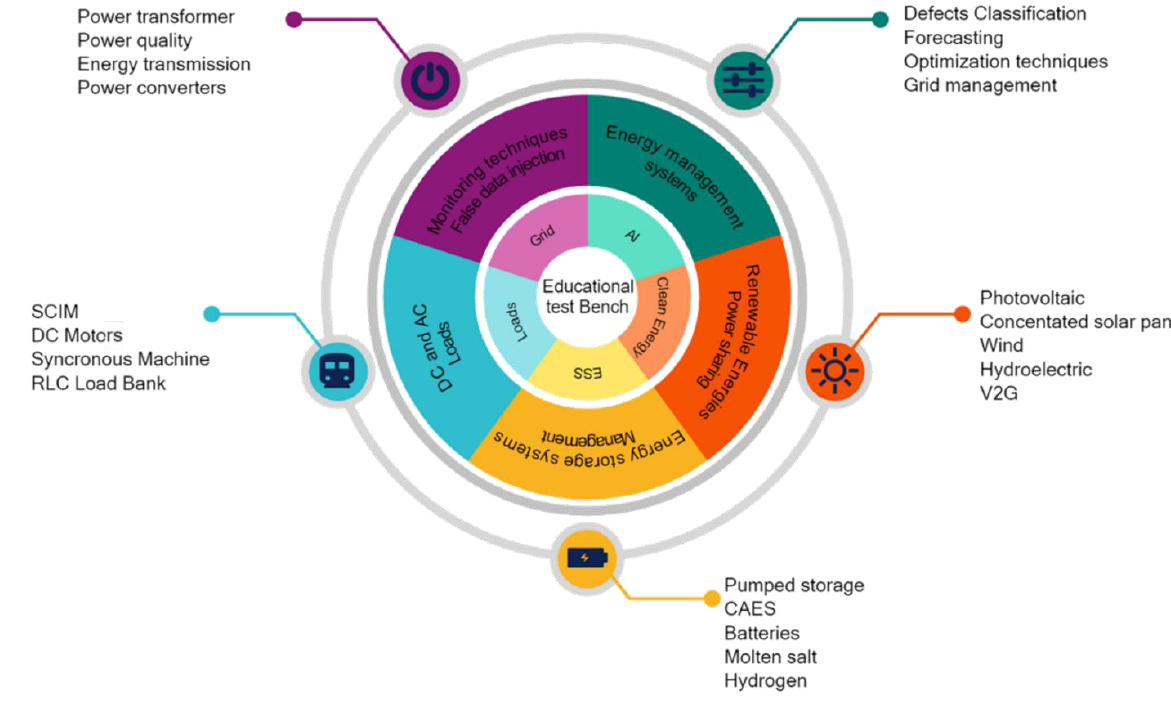
Figure 1. Educational test bench general components and features.